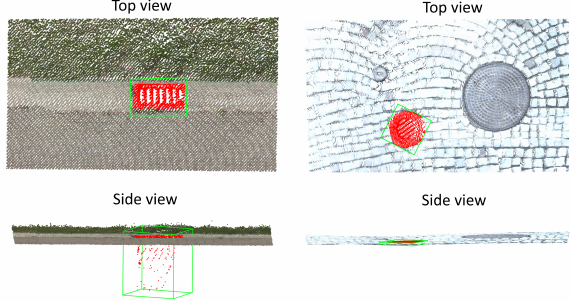
Figure 3. Difference between storm drains points in red cap- tured with MMS (left) or TLS (right). The corresponding 3D bounding box is shown in